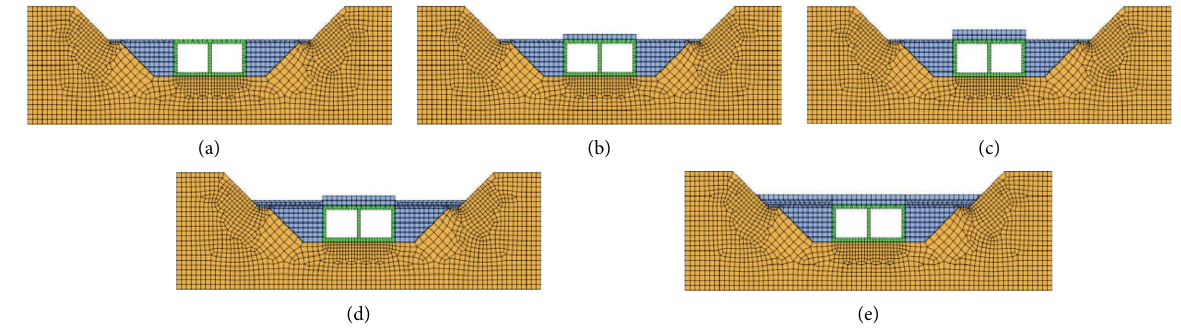
Figure 11: Backflling from the middle to both sides: Case